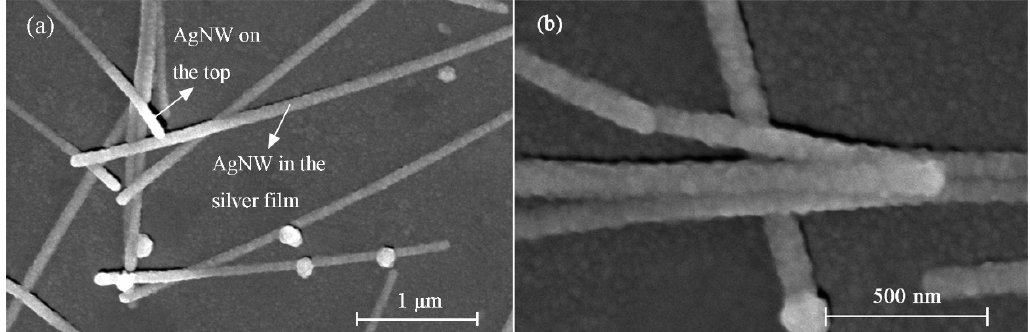
Figure 2. ( a ) Low- and ( b ) high-magnification scanning electron microscopy (SEM) images of the strain sensor showing the Ag film and silver nanowires (AgNWs).